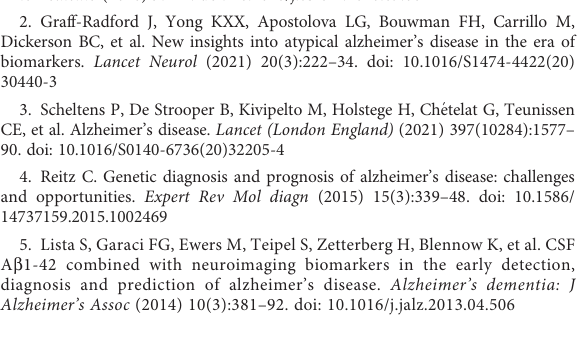
SUPPLEMENTARY TABLE 2 Plasma factors in patients with AD. SUPPLEMENTARY FIGURE 1 The correlation between ALCAM, VCAM_1 and in fl ammatory factors: (A) ROC curve between Model 6 (ALCAM +VCAM-1) and Best Model has a statistical difference (p<0.05). (B) ROC curve between Best Model and Basic Model has a signi fi cant difference (p<0.01). (C) ROC curve between the best model and the model combined with MTA (ApoE4 + Age + Education + MMSE + MTA) (AUC: 0.912) has no signi fi cant difference (p>0.05). * Y-axis of the ROC curve represents the value of sensitivity, and X-axis represents the value of (1-Speci fi